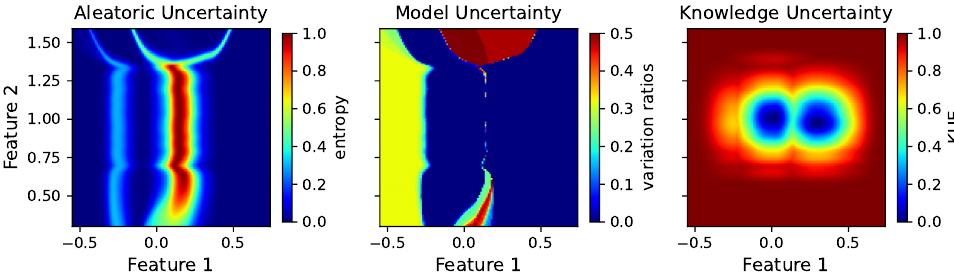
Figure 3. Toy dataset uncertainty measures for aleatoric, model, and knowledge uncertainty (from left to right